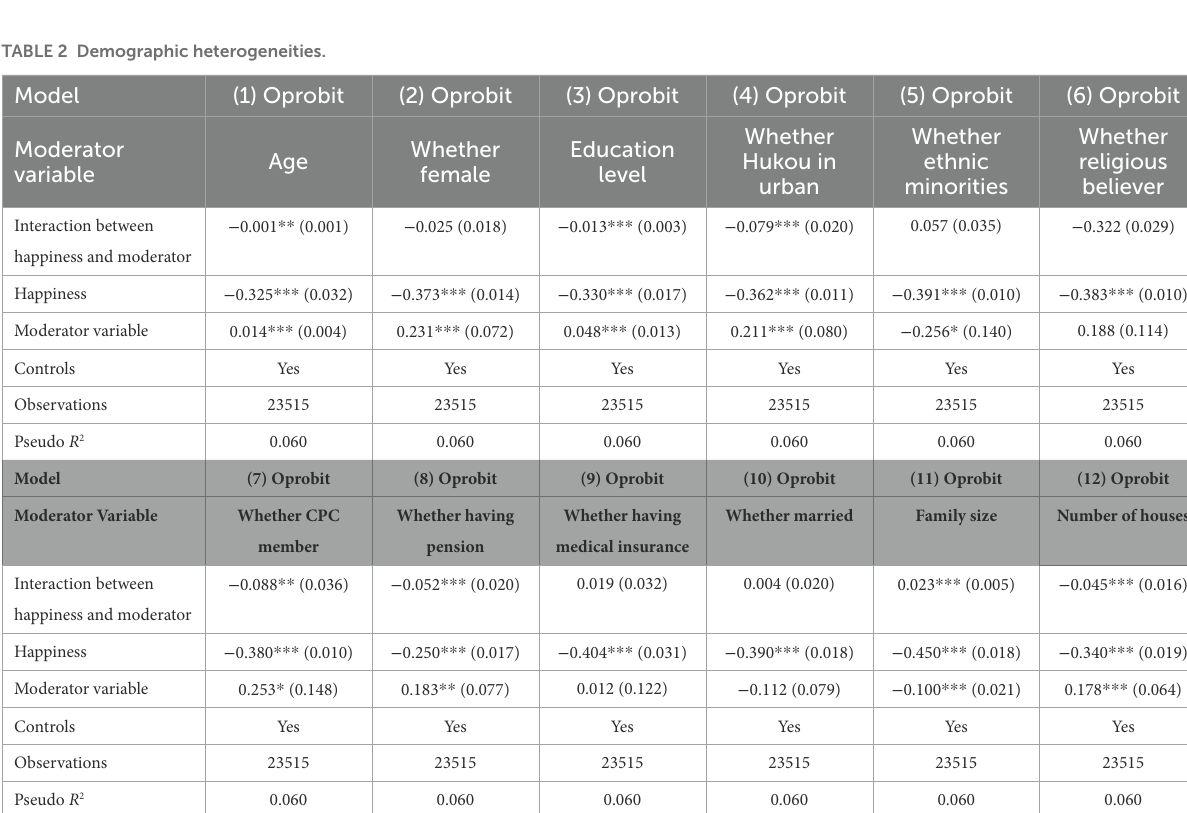
FIGURE 2 Cohort